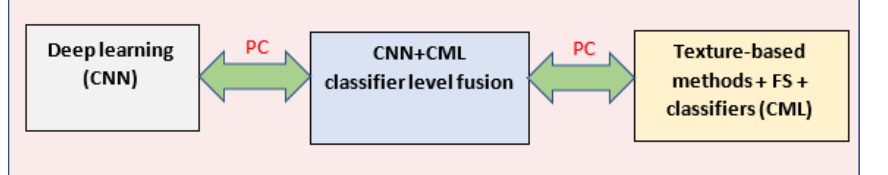
Figure 2. The graphical representation of the proposed methodology: the fusion between the CNN and CML methods (in the middle ), as well as the performance comparison (PC) with the deep learning methods ( left ) and the CML methods ( right ),